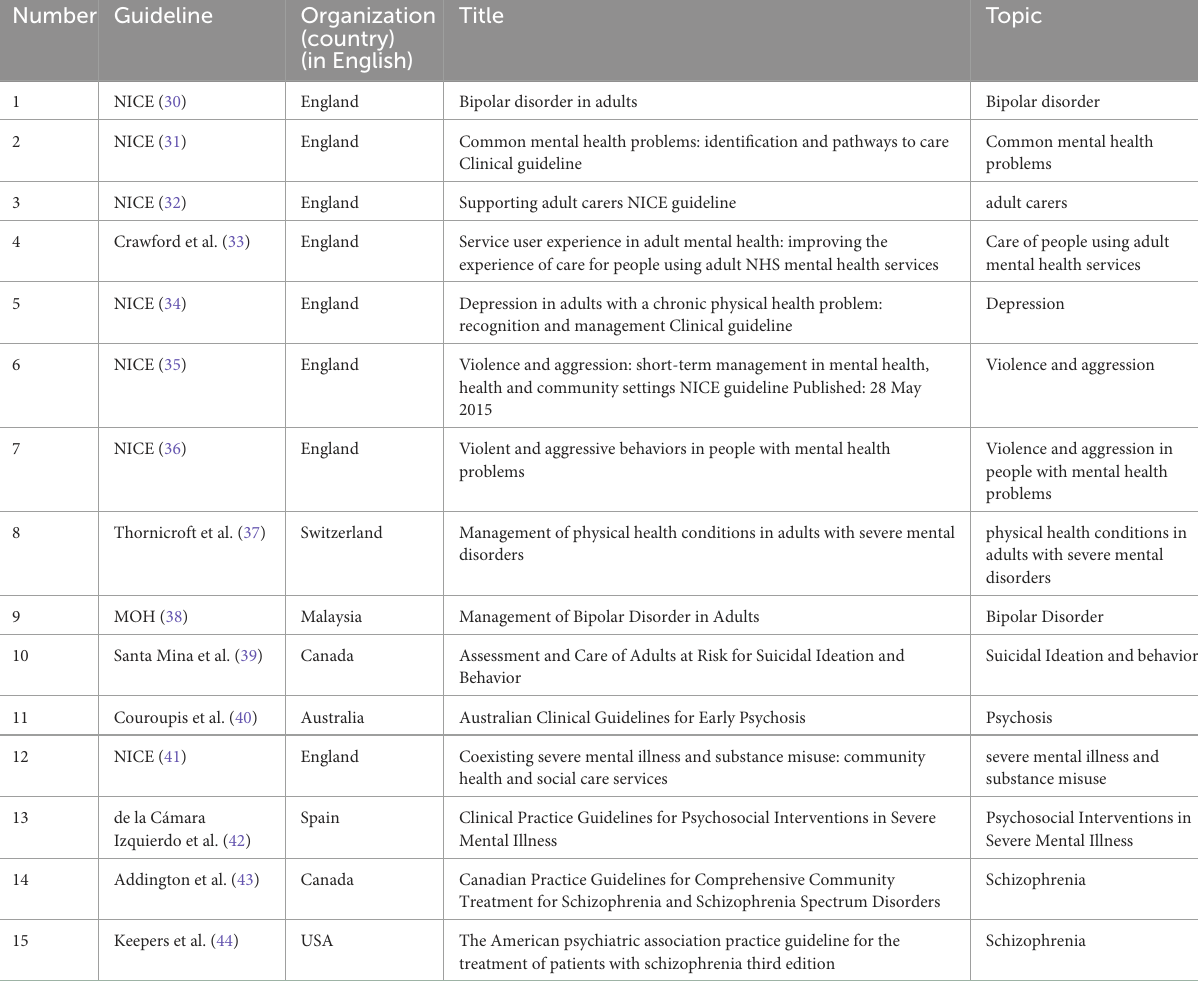
TABLE 1 Description of included guidelines with FCCC recommendations for individuals diagnosed with Schizophrenia, BMD, and MDD. Number